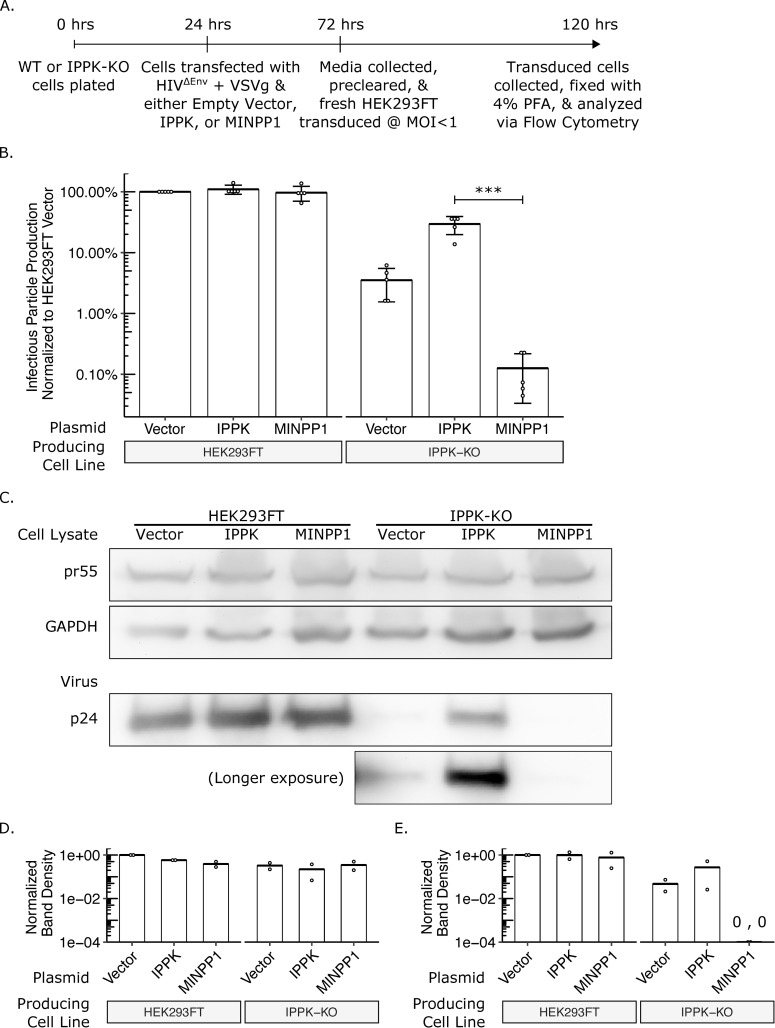
IPPK-KO cells expressing MINPP1 have substantial loss in infectious particle production due to a block in viral release.(A) Experimental timeline. (B) Bar chart of percent infectious particle release normalized to virus from HEK293FT cells expressing the empty vector. Student’s t-test was used for pair-wise comparison (n = 5, *** p < 0.001, error bars = mean ± SD). (C) Representative western blot of two experiments from panel B. The rows are full-length HIV-Gag (top), GAPDH loading control (middle), and virus released into media (bottom). A longer exposure was also taken for the blot of released virus. (D) Relative quantification of uncleaved pr55 Gag normalized to GAPDH levels in cell lysate. (E) Relative quantification of p24 Gag in virus released into media.